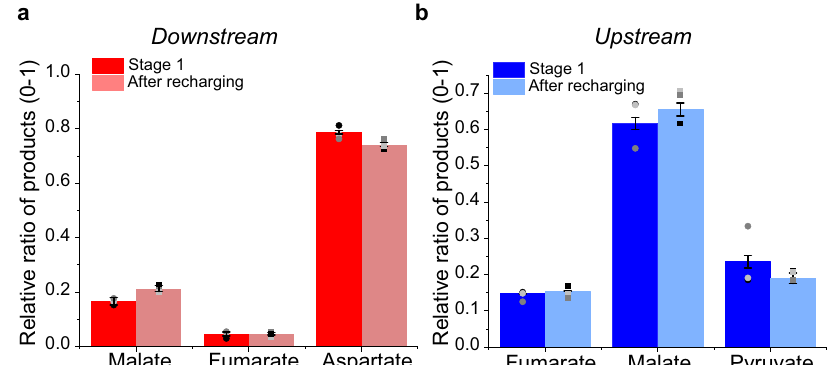
Fig. 4 Analysis of products and intermediates. Relative percentage of products in the downstream direction (reductive amination/carboxylation) ( a ), and upstream direction (oxidative deamination/decarboxylation) ( b ). In both cases, the relative product distribution was maintained after recharging the system with new buffer and substrates. Error bars represent standard errors of the mean taken from three independent repeat experiments (data points plotted as circles for stage 1 and squares after recharging, N = 3).